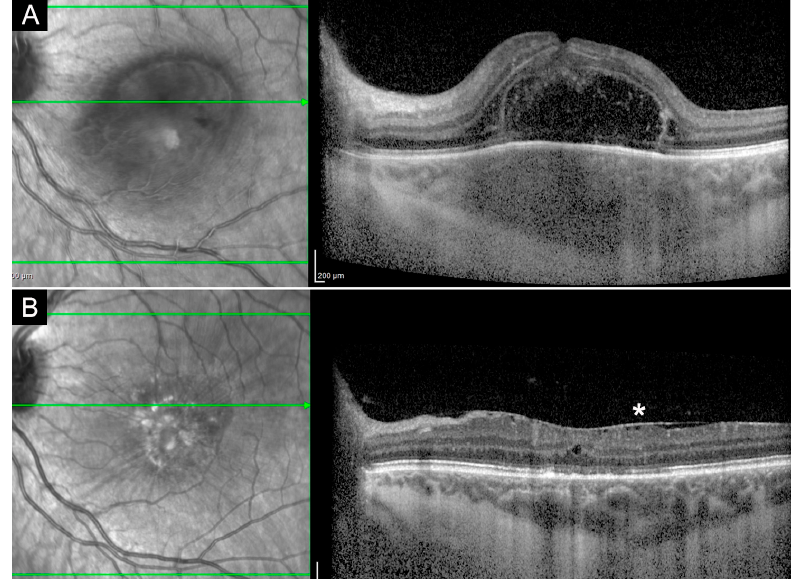
Figure 11. Case 4, Punctate outer retinal toxoplasmosis. OCT in the acute phase ( A ) showing alterations of the neurosensory retina. Hyperreflective deposits can be present within the retinal interface ( A ); during the follow-up, these deposits become smaller, enter the inner retinal layers and fade with time until complete resolution ( B ). In the active phase, the choroid is thick and hyporeflective ( A ) and returns to normal thickness during follow-up, becoming gradually hyperreflective ( B ). The presence of an epiretinal membrane ( asterisk ) is visible over the scarred lesion ( B